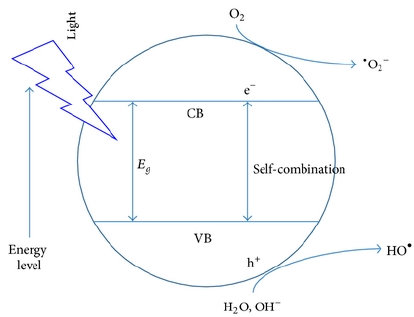
Figure 1. Photocatalyticprocess scheme [8].